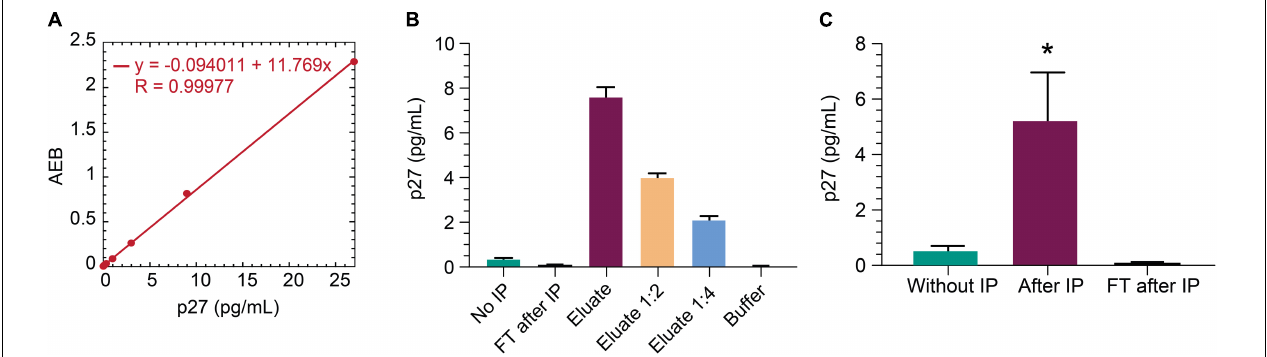
FIGURE 6 | IP-Simoa assay for SIV p27 protein measurement. (A) SIV p27 Simoa assay standard curve. Linear signal response for recombinant p27 from 0 to 28 pg/mL. (B) Recombinant p27 spiked into uninfected rhesus monkey rectal biopsy (prepared by soaking in lysis buffer) and run with IP Simoa showed enriched p27 signal proportional to the sample volume reduction (20-fold) and expected reduction of signal upon dilution indicating assay specificity. (C) p27 was enriched significantly from the lysate of viremic, SIV + monkey rectal biopsy ( p < 0.05, n = 4). No detectable p27 was observed in the flow through after IP demonstrating high efficiency of p27 IP from biopsy lysate matrix. See Materials and Methods for statistical